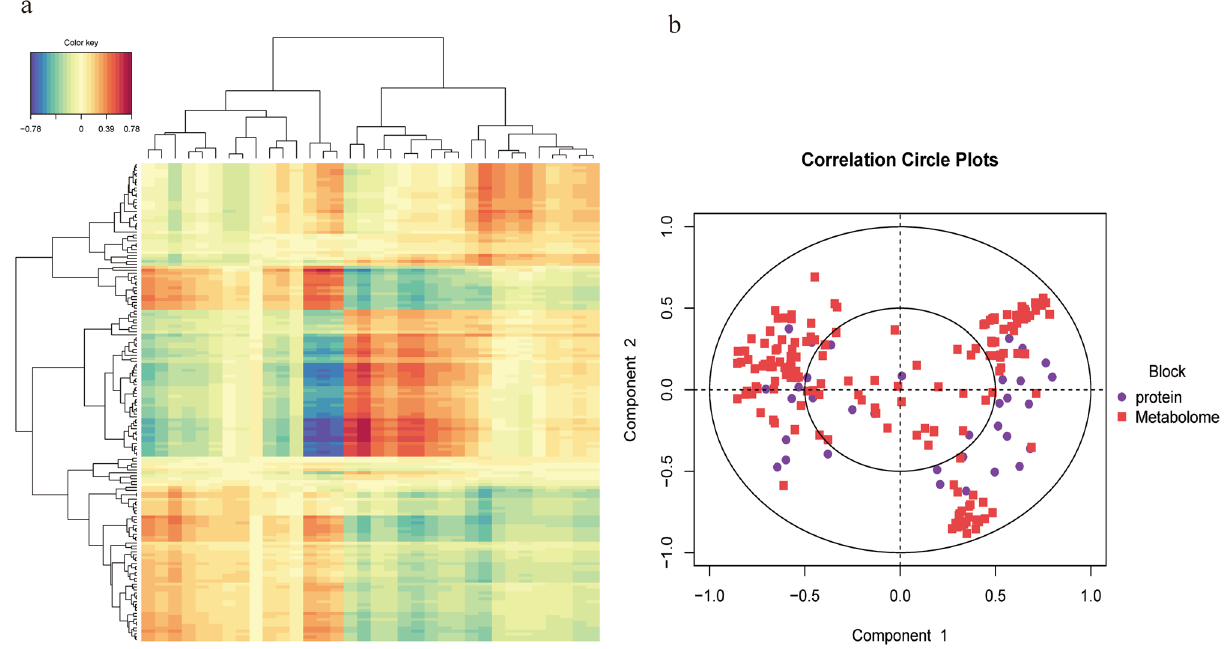
Figure 7. Association analysis of proteomics and metabolomics in Covid-19 patients with progressive pulmonary fibrosis. ( a ) Cluster heat map of the correlation between proteomics and metabolomics (“pheatmap” package in R software v3.5.0, https:// www.r- proje ct. org/). Each row denotes a differentially expressed metabolite, and each column denote a DEP. Blue, negative correlation; Red, positive correlation. ( b ) Concentric circles